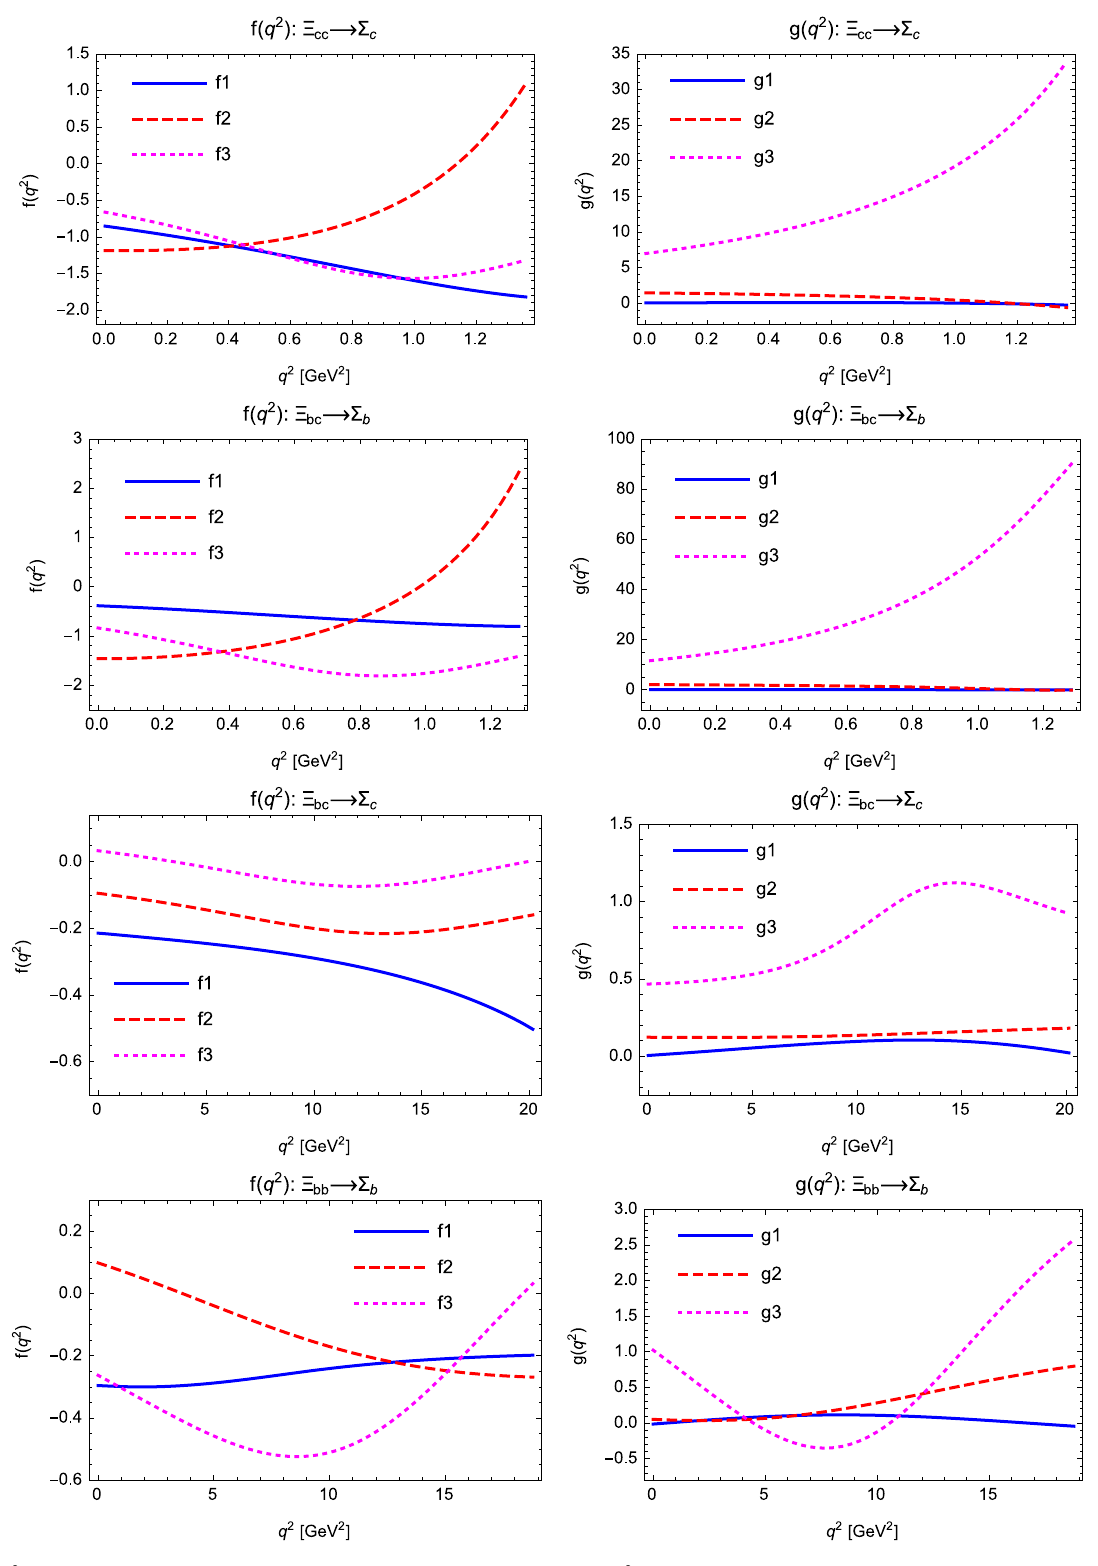
→ (cid:3) s th , M 2 are fixed at their center values as shown in Table 4. For the case Fig. 2 q 2 dependence of the (cid:2) QQ (cid:2) q Q (cid:2) q 1 q 2 form factors. The 2 first two graphs correspond to (cid:2) cc → (cid:3) c , the second two graphs corre- of (cid:2) QQ (cid:2) q → (cid:3) Q (cid:2) qq , the vertical scale needs to be enlarged by a factor spond to (cid:2) bc → (cid:3) b , the third two graphs correspond to (cid:2) bc → (cid:3) c and the fourth two graphs correspond to (cid:2) bb → (cid:3) b . Here the parameters